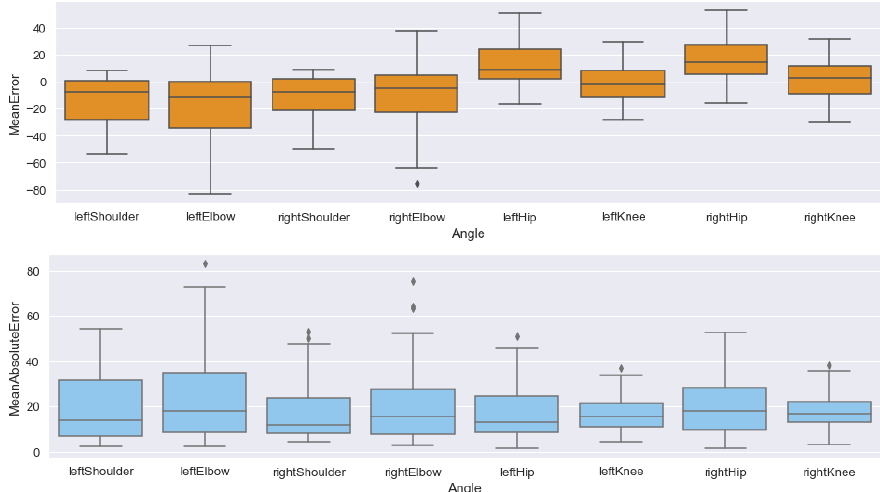
Figure 12. Boxplots representing the ME and MAE in degrees across all tracked angles in the experiments. The boxplots for the ME show a significant difference in the means of the upper and lower body angles, which is not visible for the MAE.